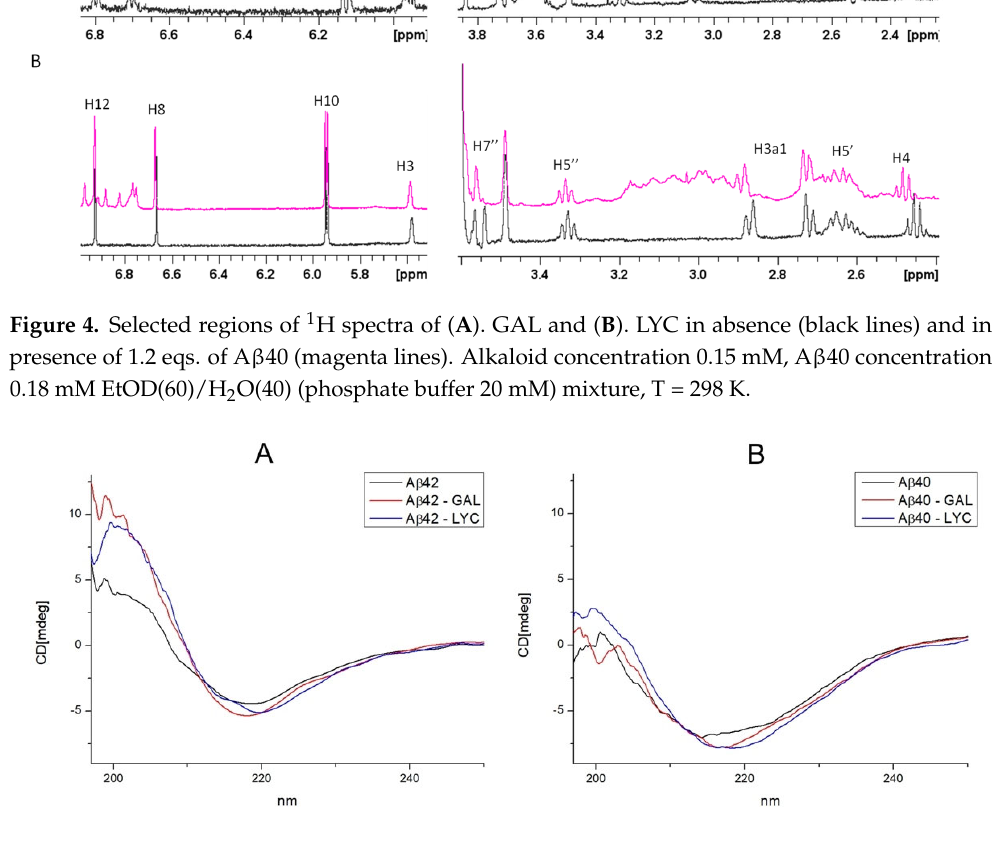
Figure 4. Selected regions of 1 H spectra of A . GAL and B . LYC in absence (black lines) and in presence of 1.2 eqs. of A β 40 (magenta lines). Alkaloid concentration 0.15 mM, A β 40 concentration 0.18 mM EtOD(60)/H 2 O(40) (phosphate buffer 20 mM) mixture, T = 298 K.